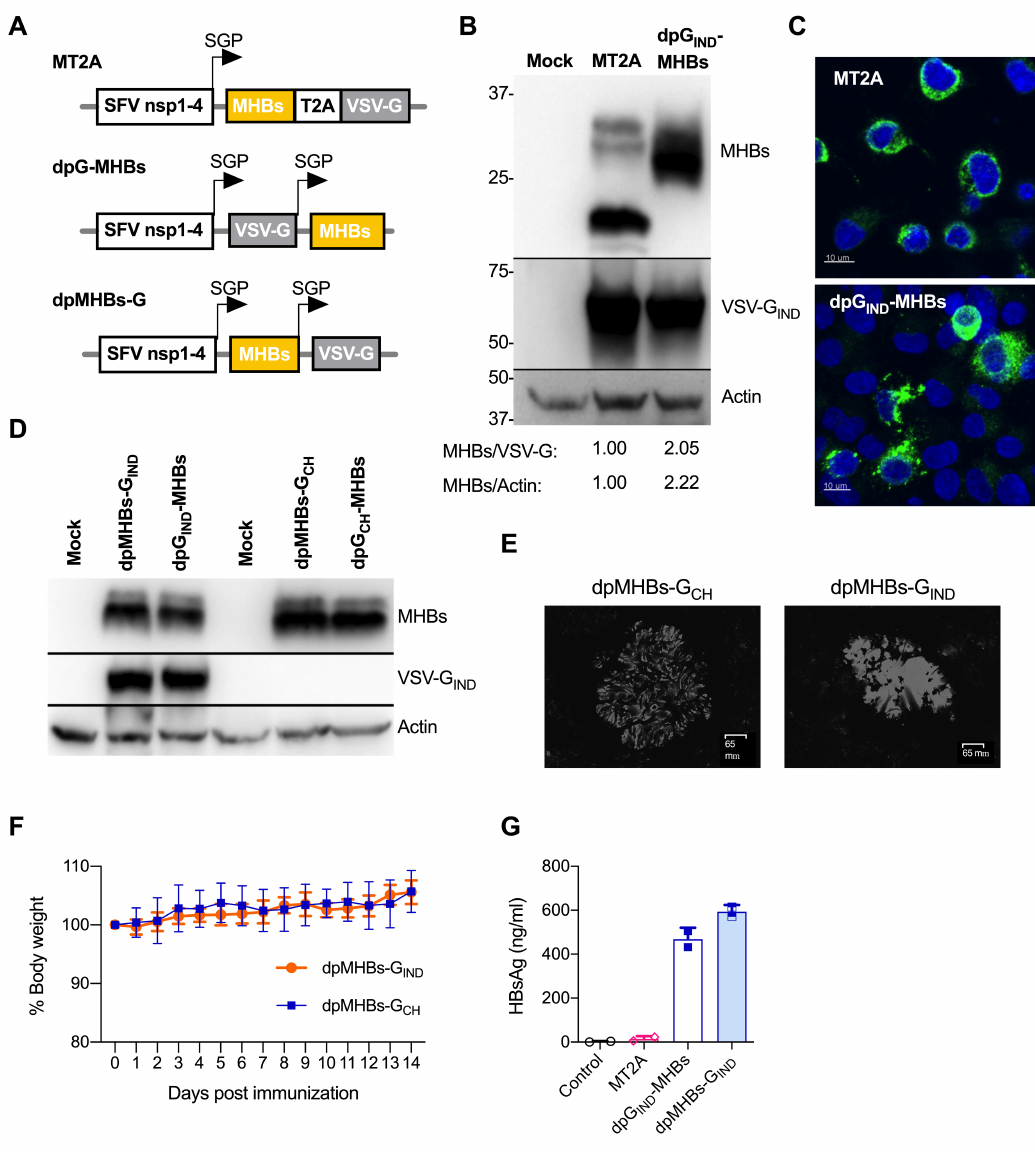
Figure 1. Improved MHBs expression and secretion using VLV dp vectors. ( A ) Schematic of the double subgenomic promoter (SGP) VLV vectors used in this study. ( B ) Immunoblot analyses of MHBs and VSV-G expression in BHK-21 cells at 24 h post-infection with MT2A or dpG IND -MHBs VLV (MOI = 1). Densitometry values are for MHBs signal (PreS2) relative to VSV-G or actin. ( C ) Immunofluorescence analyses of MHBs expression (green) in BHK-21 cells at 18 h post-infection with MT2A or dpG IND -MHBs VLV at MOI = 0.5. Nuclear counterstaining (DAPI) is shown in blue. ( D ) MHBs expression in BHK-21 cells at 24 h after infection with dp VLV with serotype switch of the envelope glycoprotein from Indiana to Chandipura (IND vs. CH) or position of MHBs (all at MOI = 1). ( E ) Representative plaques from VLV dpMHBs-G CH and VLV dpMHBs-G IND in BHK-21 cells. Plaques were stained with crystal violet and images were obtained using a ZOE fluorescent cell imager (Bio-Rad laboratories). ( F ) Percentage of body weight after intranasal infection with VLV dpMHBs-G CH and VLV dpMHBs-G IND . ( G ) Secretion of MHBs measured by ELISA using conditioned media from BHK-21 cells infected with the indicated VLV (all at MOI =